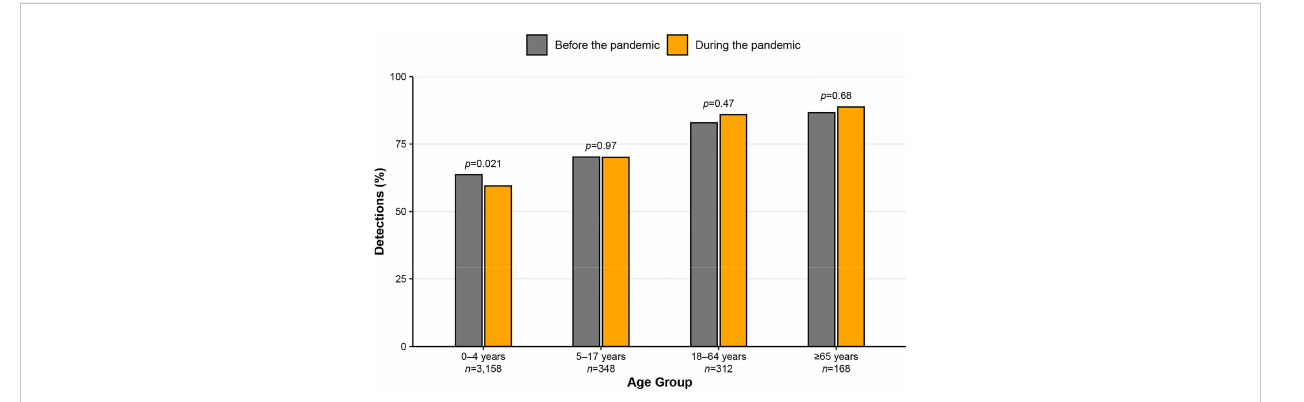
FIGURE 2 Proportions of samples testing positive for only respiratory syncytial virus (RSV; among all RSV-positive samples) before and during the COVID-19 pandemic, strati fi ed by age group. Samples were tested from January 2018 to November 2022 in Nashville,